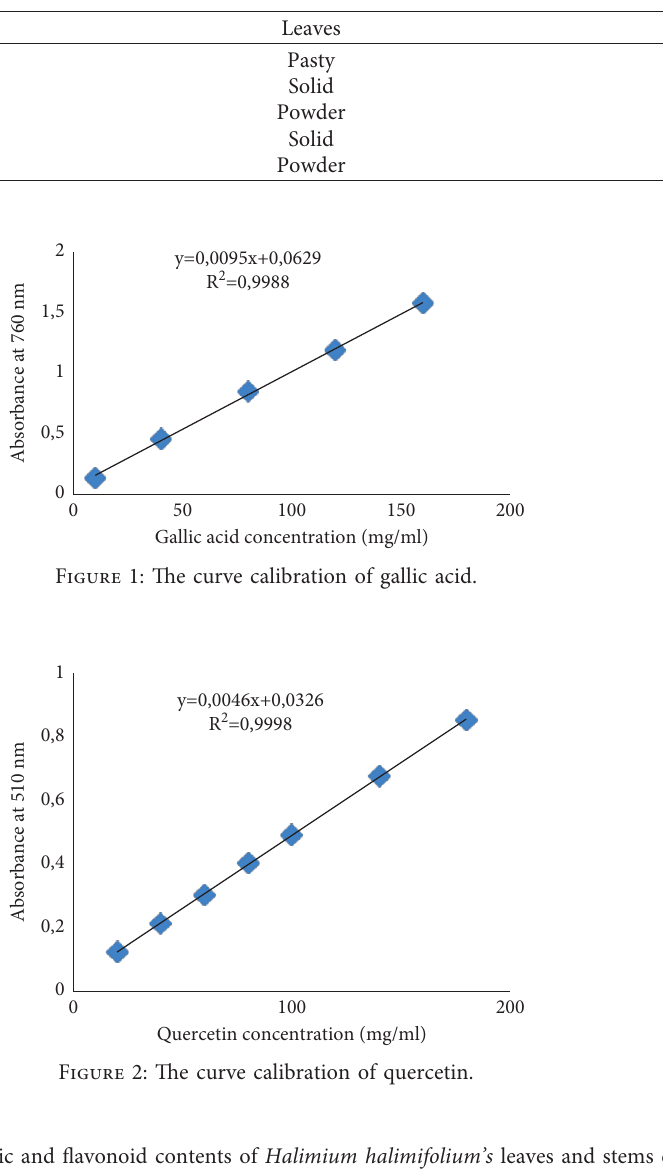
Table 4: The aspects of crude extract.